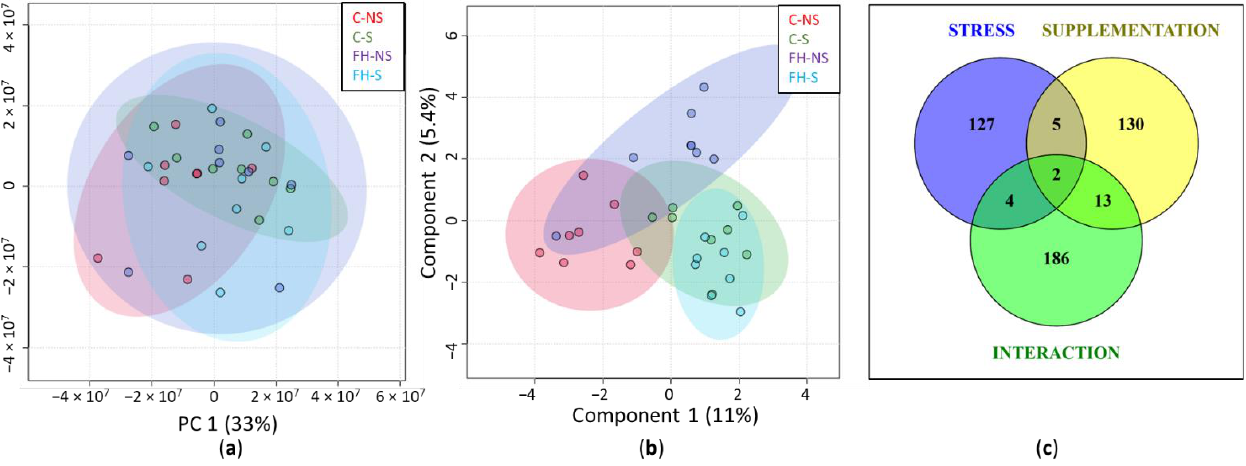
Figure 2. Evaluation of quantified hippocampal proteins ( n = 4149). ( a ) Graphic representation defined by the first two principal components (PC1 and 2) of the principal component analysis (PCA). ( b ) Graphic representation defined by the first two components (1 and 2) of the sparse partial least squares discriminant analysis (sPLS-DA). ( c ) Venn diagram representing the differential proteins ( p < 0.05) for stress, supplementation, and interaction of Stress × Supplementation after two-way ANOVA analysis.